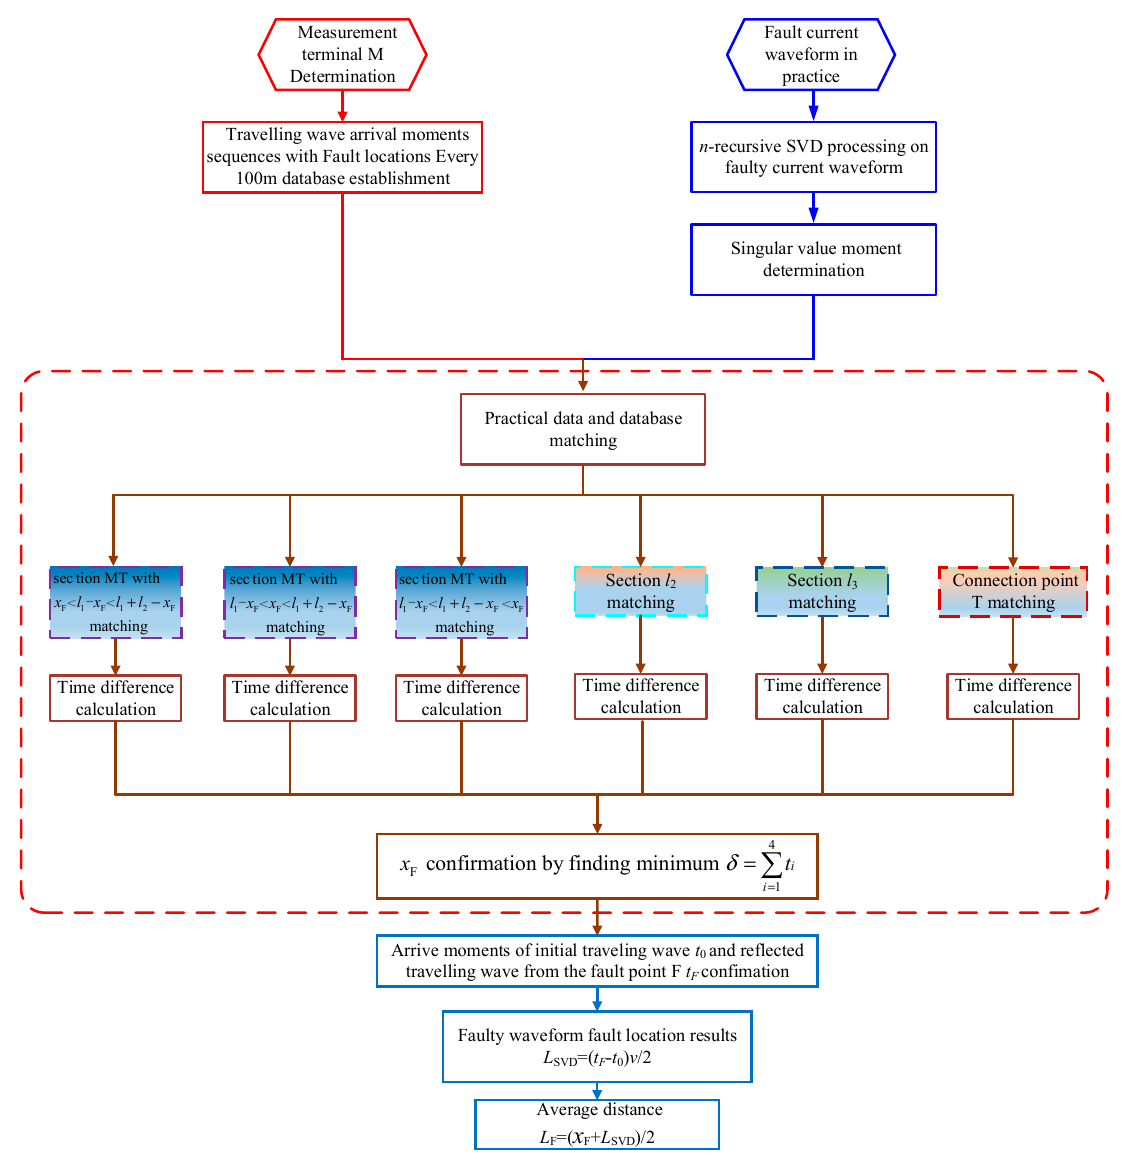
Figure 8. Flow chart of full-line matching algorithm.